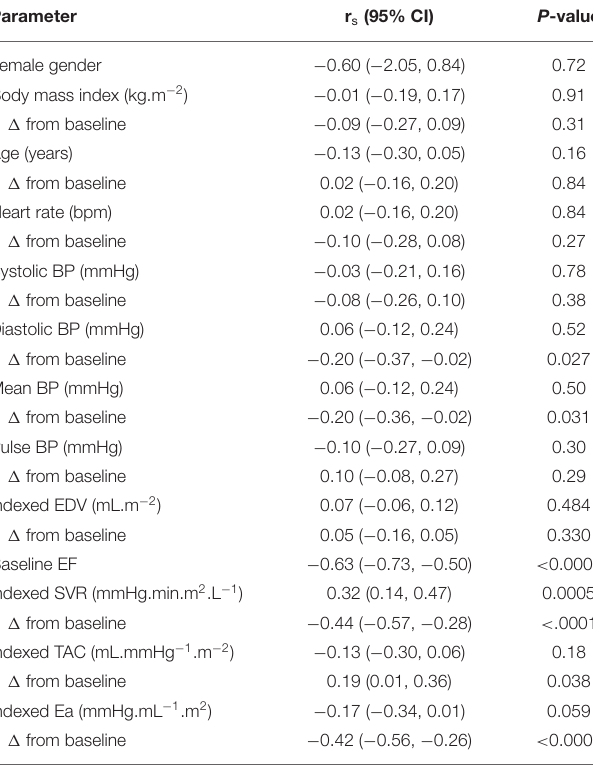
TABLE 3 | Linear regression models obtained through forward selections, with Beta coefficients [standard error (SE)], P and R 2 values, for predicting